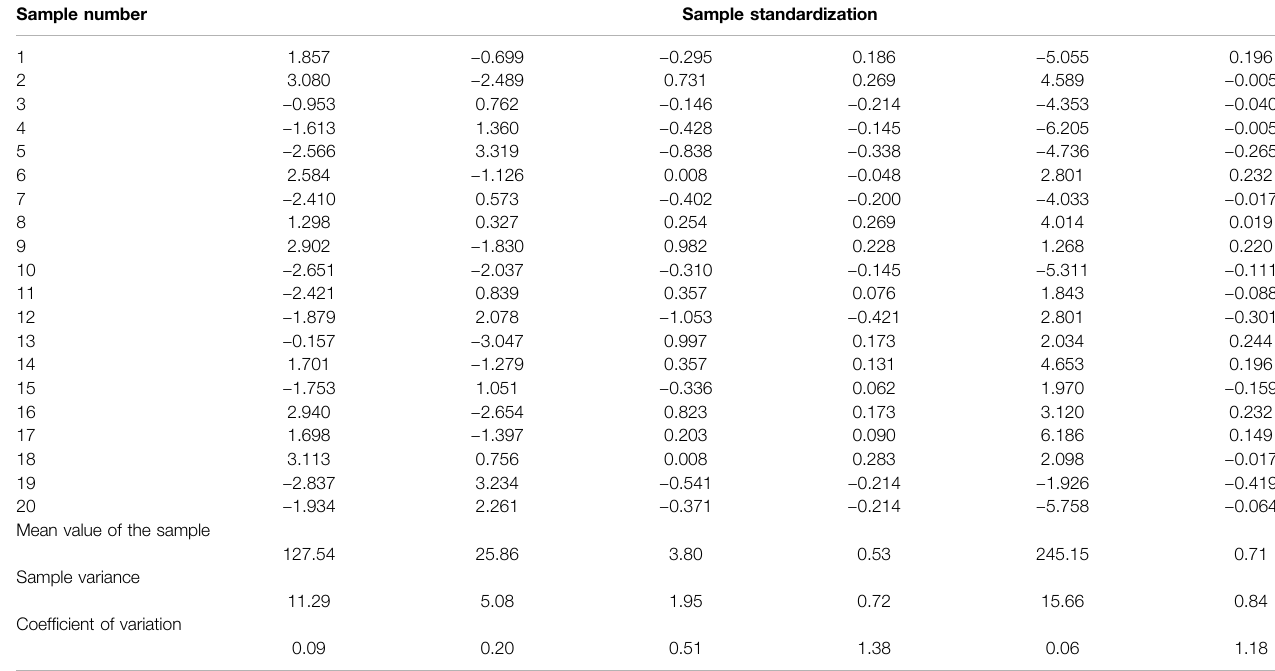
TABLE 4 | Sample-normalized index values and CRITIC algorithm index parameters.